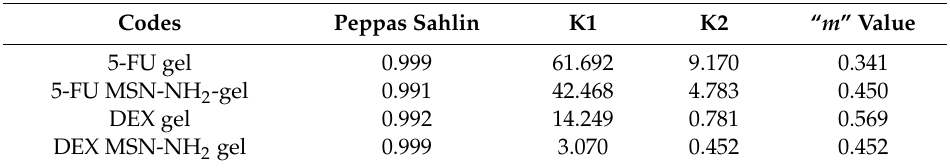
Table 3. Release kinetics of free formulations, 5-FU MSN-NH 2 , and DEX MSN-NH 2 loaded using Peppas–Sahlin kinetic model.